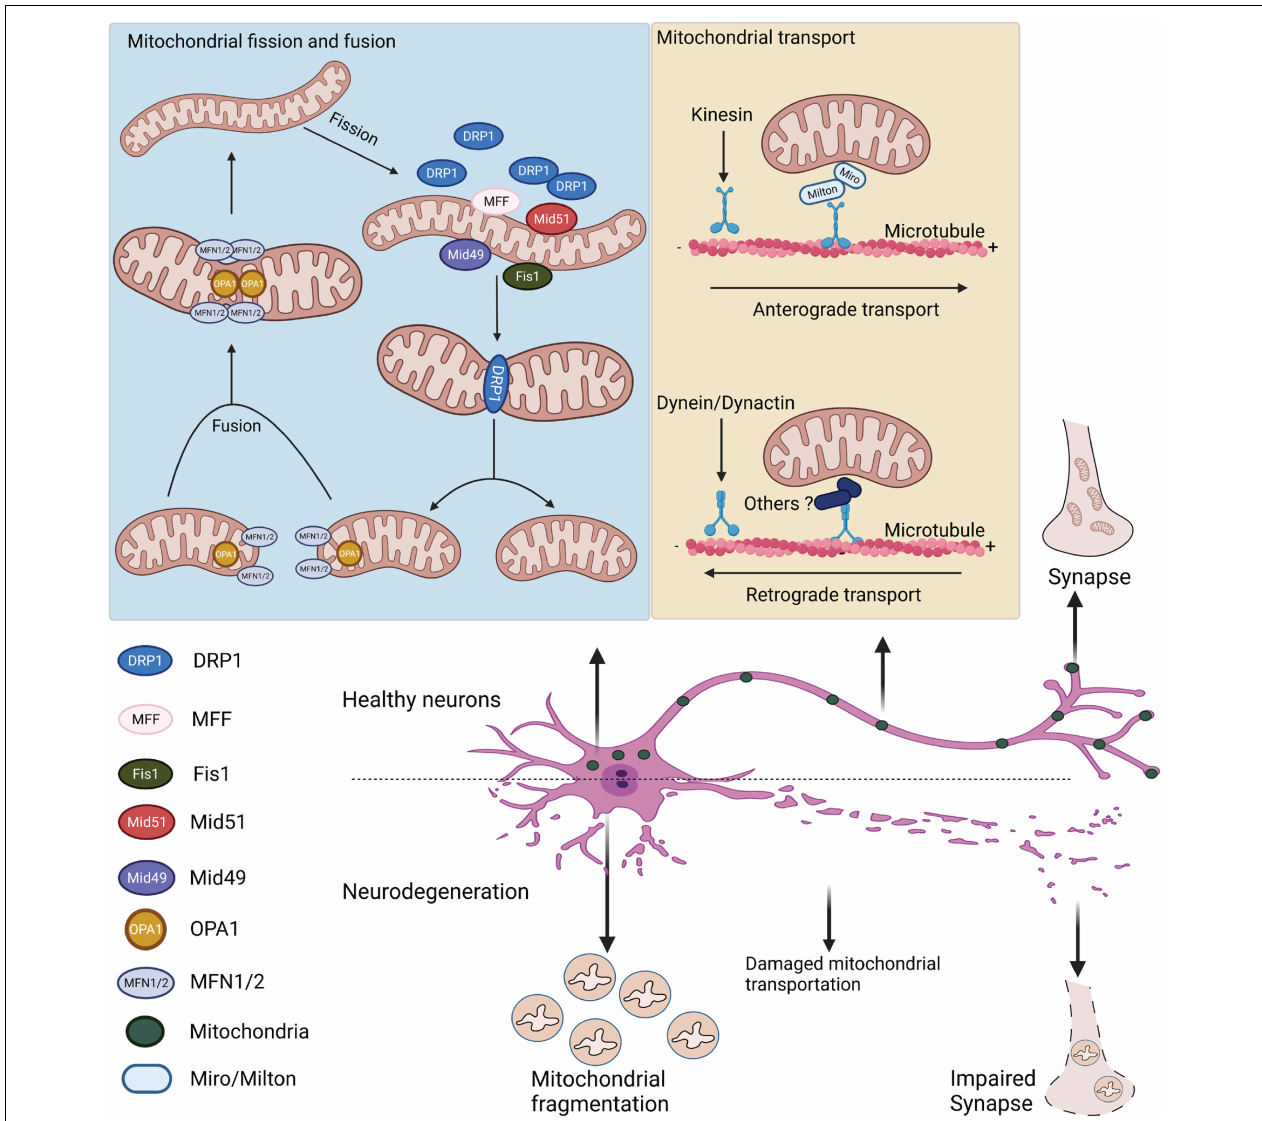
FIGURE 2 | Mitochondrial fission, fusion, and transport in healthy and degenerative neurons. Mitochondrial fusion is mainly mediated by MFN1/2 and OPA1 on the outer and inner mitochondrial membranes, respectively. Mitochondrial fission is regulated by cytosolic DRP1 and its adaptor proteins (e.g., MFF, Fis1, and Mid49/51) on the OMM. After translocating onto mitochondria, DRP1 assembles to constrict the mitochondrial membrane. Mitochondrial axonal transport is mediated by the motor-adaptor protein complex. Anterograde transport is regulated by kinesin motor and Miro/Milton adaptors, whereas retrograde transport is regulated by the dynein/dynactin protein complex. In neurodegenerative diseases, dysregulated mitochondrial dynamics leads to mitochondrial fragmentation and impaired mitochondrial transport in